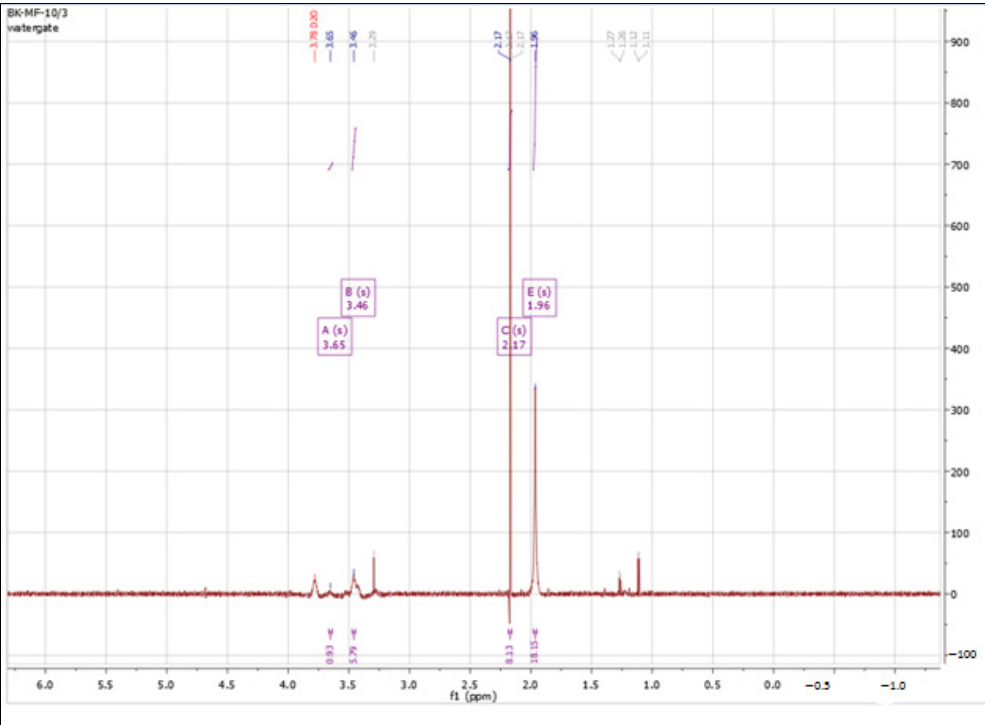
Figure 1. 1 H NMR spectrum of unmodified HA in D 2 O. Spectrum recorded with MestReNova 9.0 software .